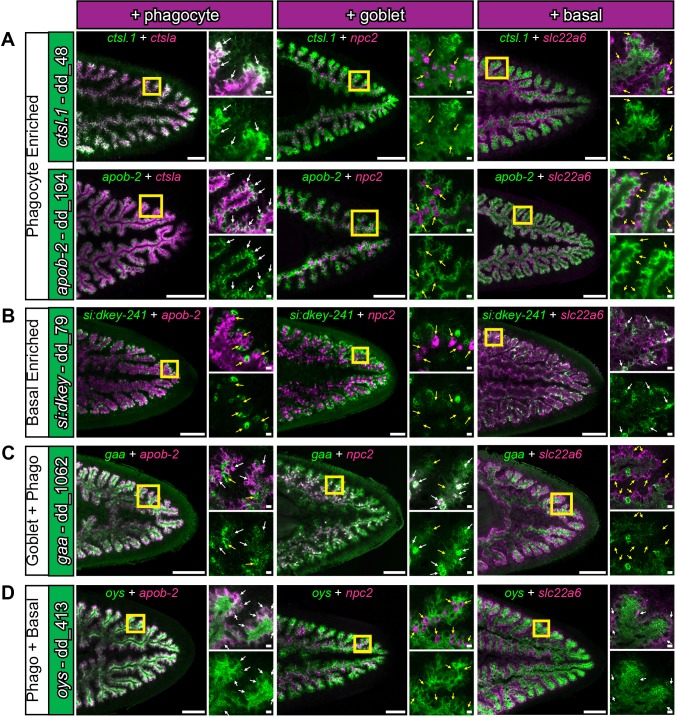
Additional cell-type specific transcripts revealed by double fluorescent in situ hybridization.(A) Phagocyte-enriched genes ctsl.1 and apob-2 (green), in combination with a phagocyte, goblet, or basal marker shown in Figure 5 (magenta). Yellow box indicates magnified region. White arrows indicate regions of considerable overlapping expression, while yellow arrows indicate regions of minimal overlap. (B) si:dkey-241 (green) is enriched in a subset of slc22a6-positive basal cells. (C) gaa (green) is expressed in both goblet cells (high) and phagocytes (moderate), but is largely absent in basal cells. (D) oys is expressed in both phagocytes and basal cells. Detailed gene ID information is available in Supplementary file 1. Scale bars, whole animals 200 μm; magnified images, 10 µm.